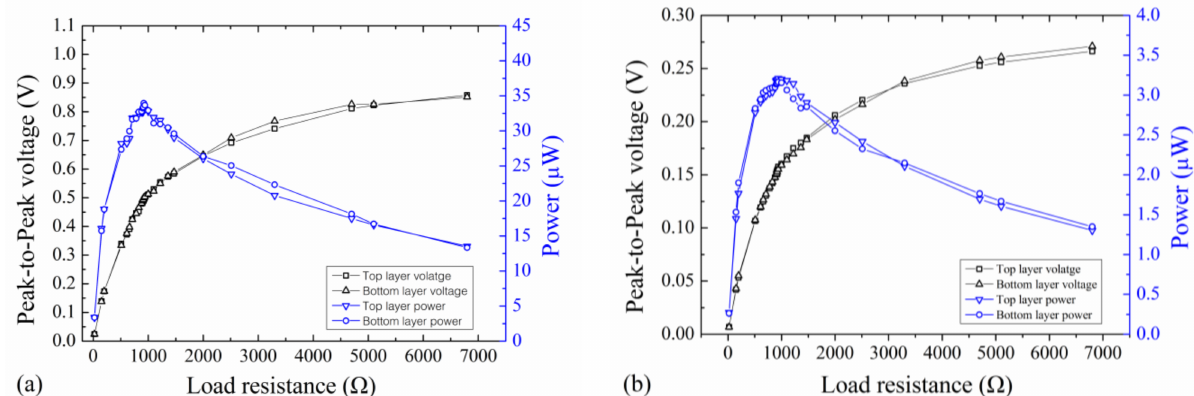
Figure 8. The closed-circuit output voltage and power of the EVEH as a function of load resistance on ( a ) Z direction and ( b ) X